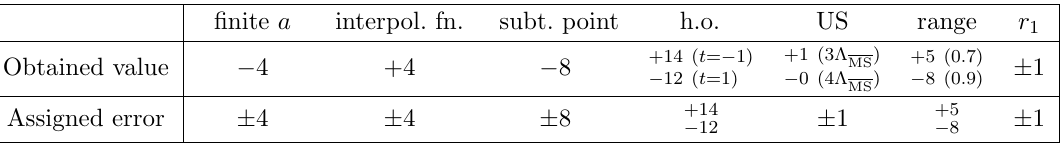
Table 5 . Estimates of systematic errors in Analysis (I) from variations of the central value of (cid:11) s ( M 2 ) in units of 10 (cid:0) 4 when varying the analysis conditions. In the upper row, variations are Z shown. (Detailed conditions are shown inside brackets). Assigned systematic errors are shown in the lower